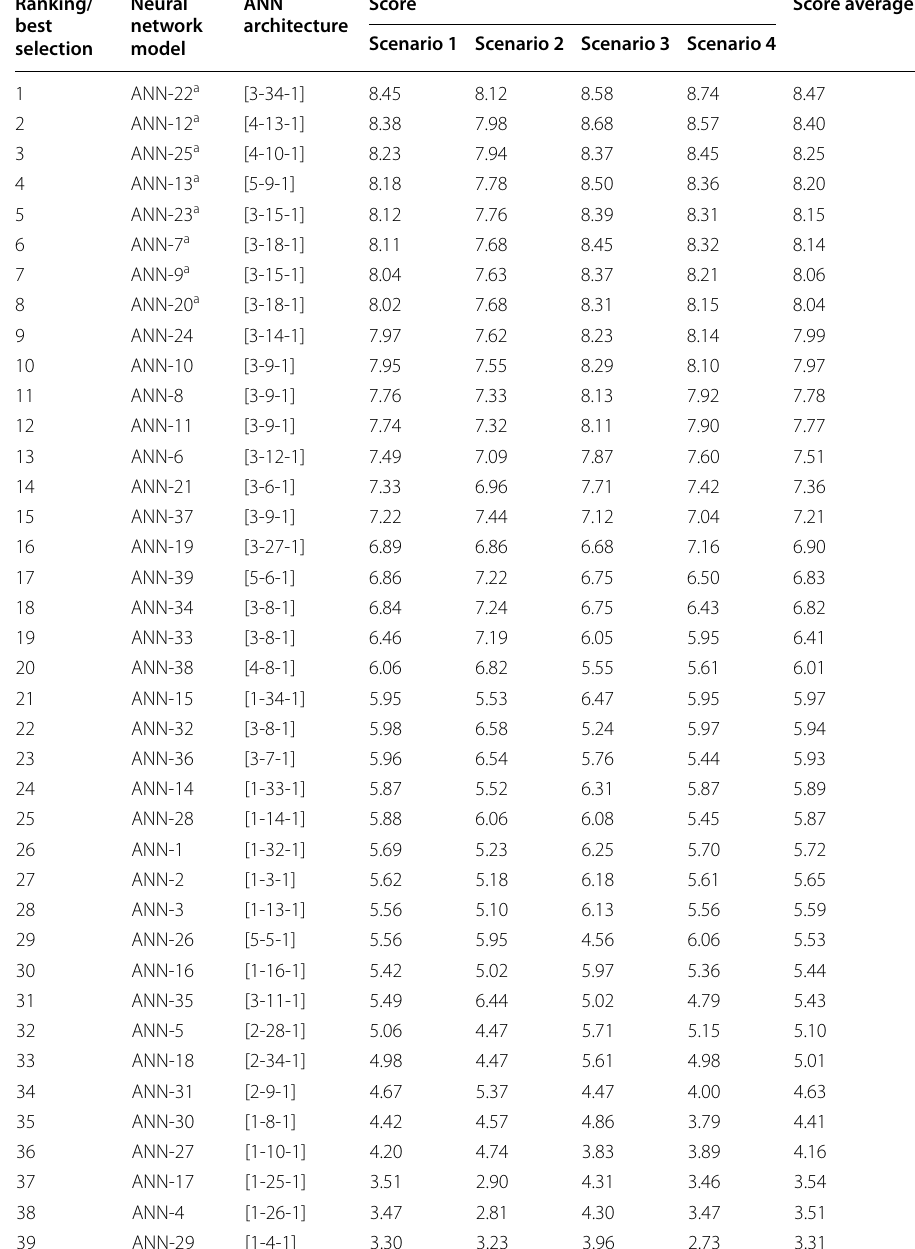
Table 5 Ranking score and optimal selection of the eight ANN architectures using the MCDA